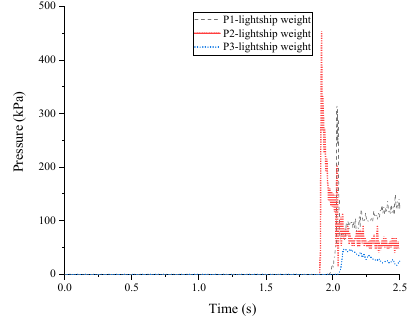
Figure 12. Pressure at P1, P2 and P3 in the case of lightship weight.